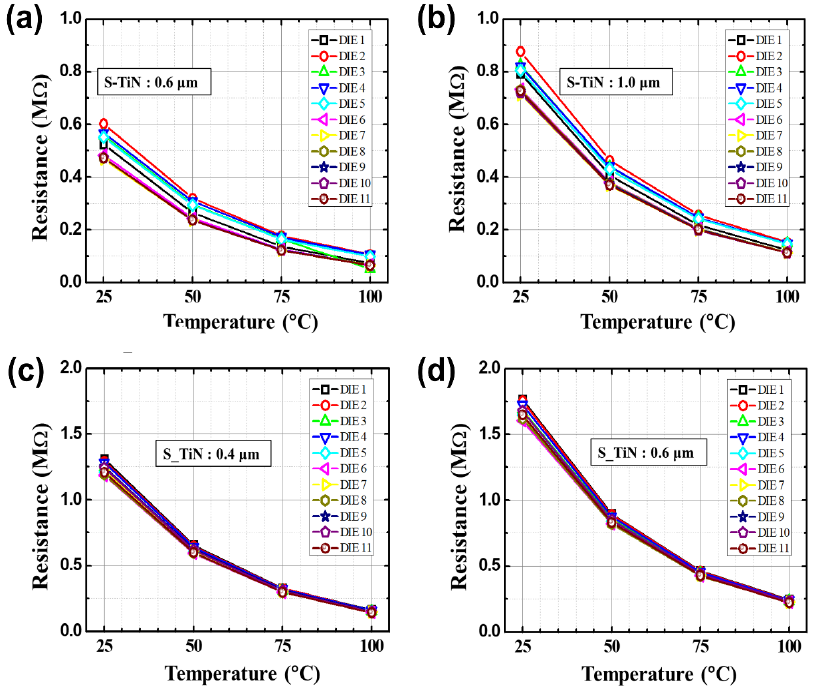
6 of 13 Table 1. The anode current at 3 V according to the temperature of the four types of a-Si microbo- lometers.